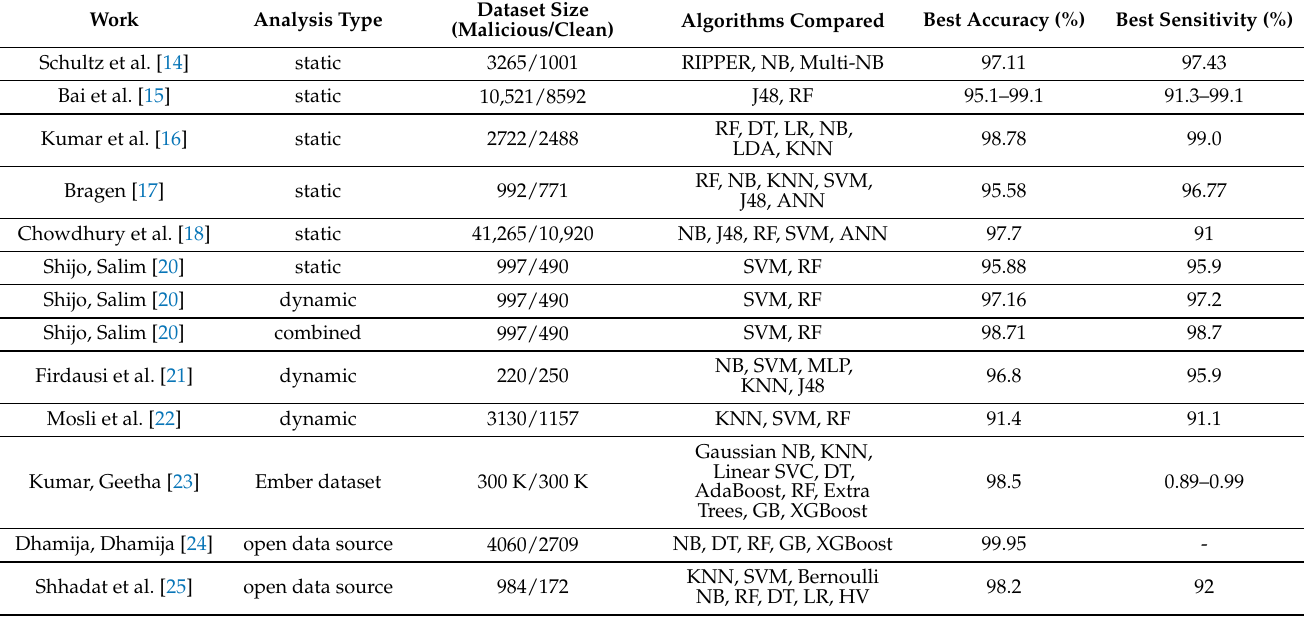
Table 1. Overview of existing